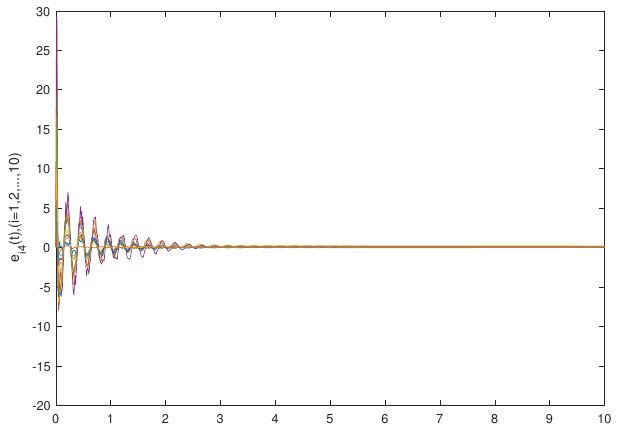
Figure 18. Synchronization errors e i 4 ( i = 1,2, · · · ,10 ) of the fractional-order system (34) and (35) with the